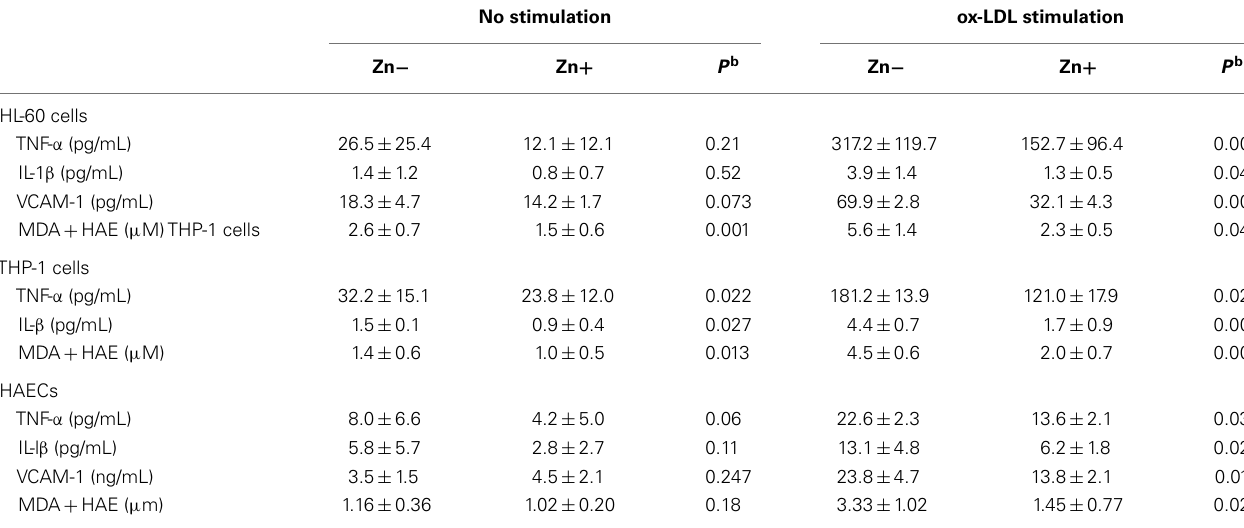
Table 6 | Effect of zinc on tumor necrosis factor- α (TNF- α ), interleukin-1 β (IL-1 β ), vascular cell adhesion molecule 1 (VCAM-1), and malondialdehyde and hydroxyalkenals (MDA + HAE) in HL-60 andTHP-1 cells and human aortic endothelial cells (HAECs) a (6) . No stimulation ox-LDL